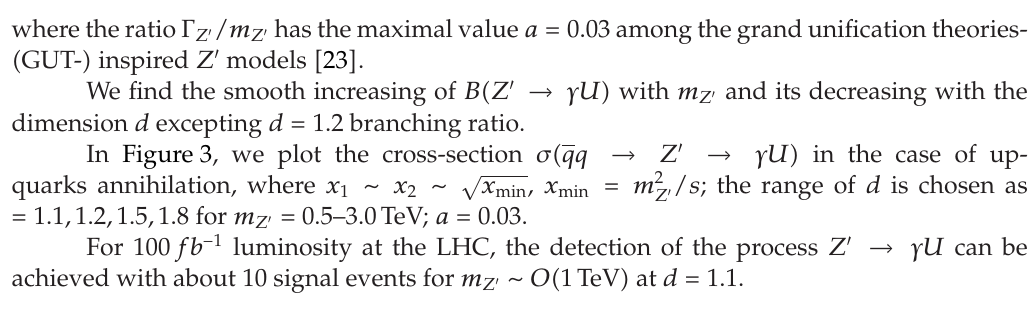
Figure 3: Cross-section σ (cid:4) qq → Z (cid:2) → γU (cid:5) × 10 2 ,fb with the assumption of up quarks annihilation, where d (cid:10) 1 . 1 , 1 . 2 , 1 . 5 , 1 . 8, m Z (cid:2) (cid:10) 0 . 5–3 . 0TeV, a (cid:10) 0 .